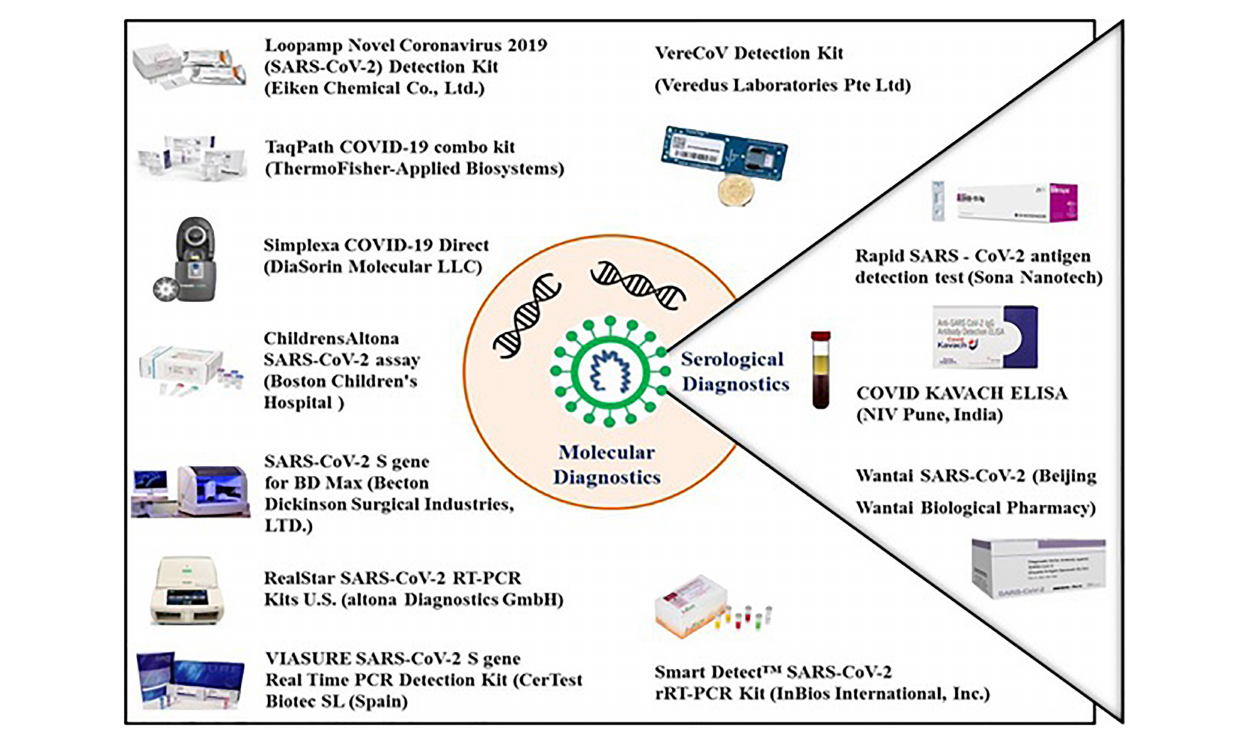
FIGURE 2 | Molecular and serological diagnostic kits available for the detection of COVID-19. All the molecular diagnostic kits available as of the date of this publication are based on real-time RT PCR which detects the viral antigens with very high sensitivity as well as specificity. The serological kits are based on detection of antiviral specific antibodies and viral surface antigens. The antigen detection test kit identifies the viral surface protein in patient samples with the help of surface protein specific antibodies while the antibody detection kits identifies the viral surface protein specific IgG/IgM antibodies in the blood of an infected individual.